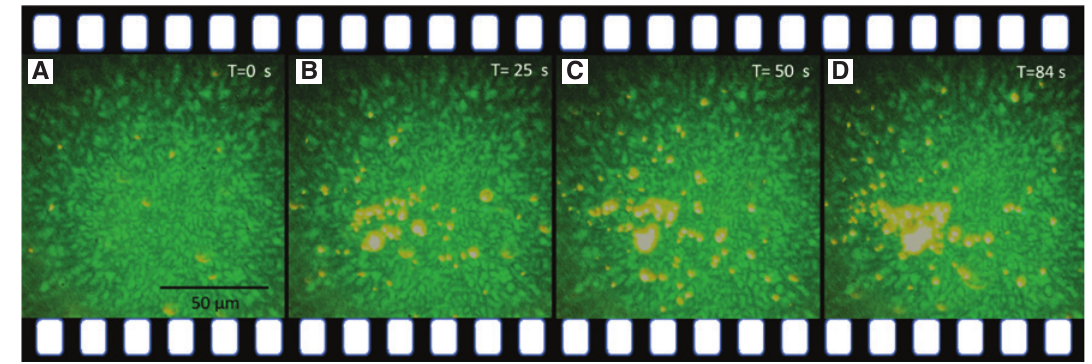
Figure 3: Size-based filtration of nanoparticles using opto-thermoelectric speckle tweezers. (A–D) Time-lapsed images showing that a thermal speckle field could selectively trap a large number of 200-nm nanoparticles from the mixed solution of 200-nm and 1- μ m polystyrene particles flowed in an AuNI-embedded microfluidic channel, which enabled large-scale separation or filtration of nanoparticles based on